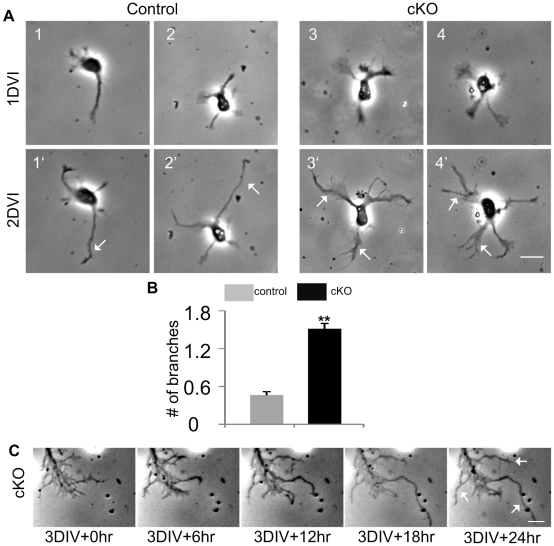
APC deletion induces growth cone splitting.(A) Representative images of the same neurons taken at 1DIV (top panel) and 2DIV (bottom panel) from control and APC deleted embryos. Note that control growth cones normally remain intact (1′ and 2′, arrows) at 2DIV, while APC deficient growth cones split into multiple branches (3′ and 4′, arrows). (B) The average number of branches that emanated from control and APC deficient growth cones at 2DIV. (C) Phase-contrast images of an APC cKO axon observed over 24 hr in time lapse. Cortical neurons from around E15 embryos were cultured for 3 days in vitro before imaging. **: P<0.005 by two-tailed student t-test. Data are presented as mean ± SEM. Scale bars: 20 µm.